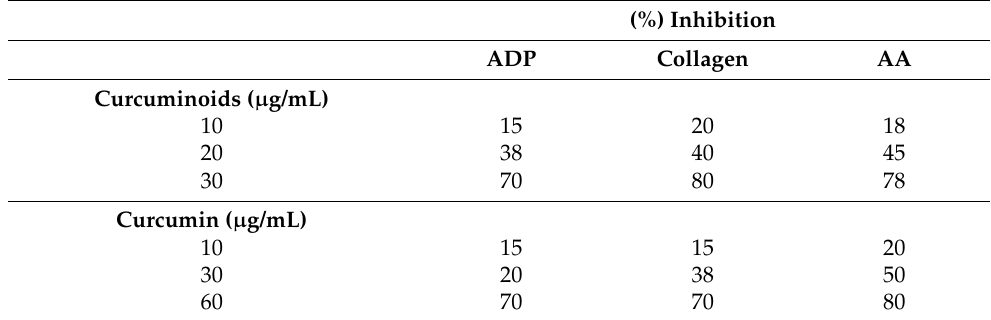
Table 7. Inhibitory effects of curcuminoids and curcumin on rat PRP aggregation [132].